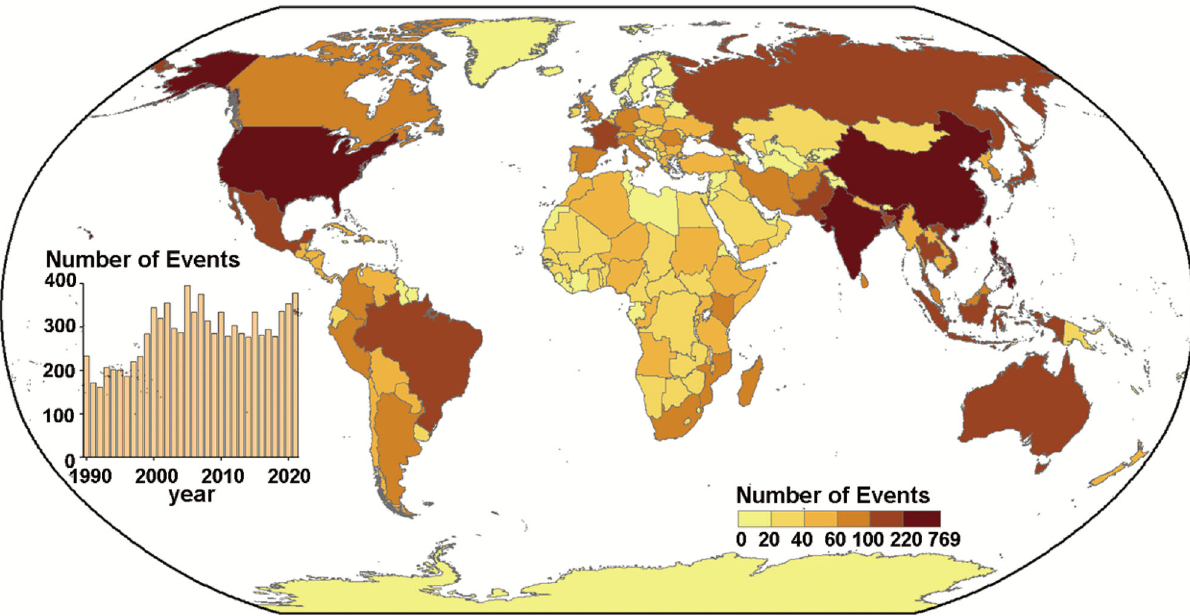
Fig. 1 Countries/regions affected by extreme weather events, mainly storms and fl oods, droughts, extreme temperatures, and wild fi res, over the last three decades (1990 – 2021). Data source: The International Disaster